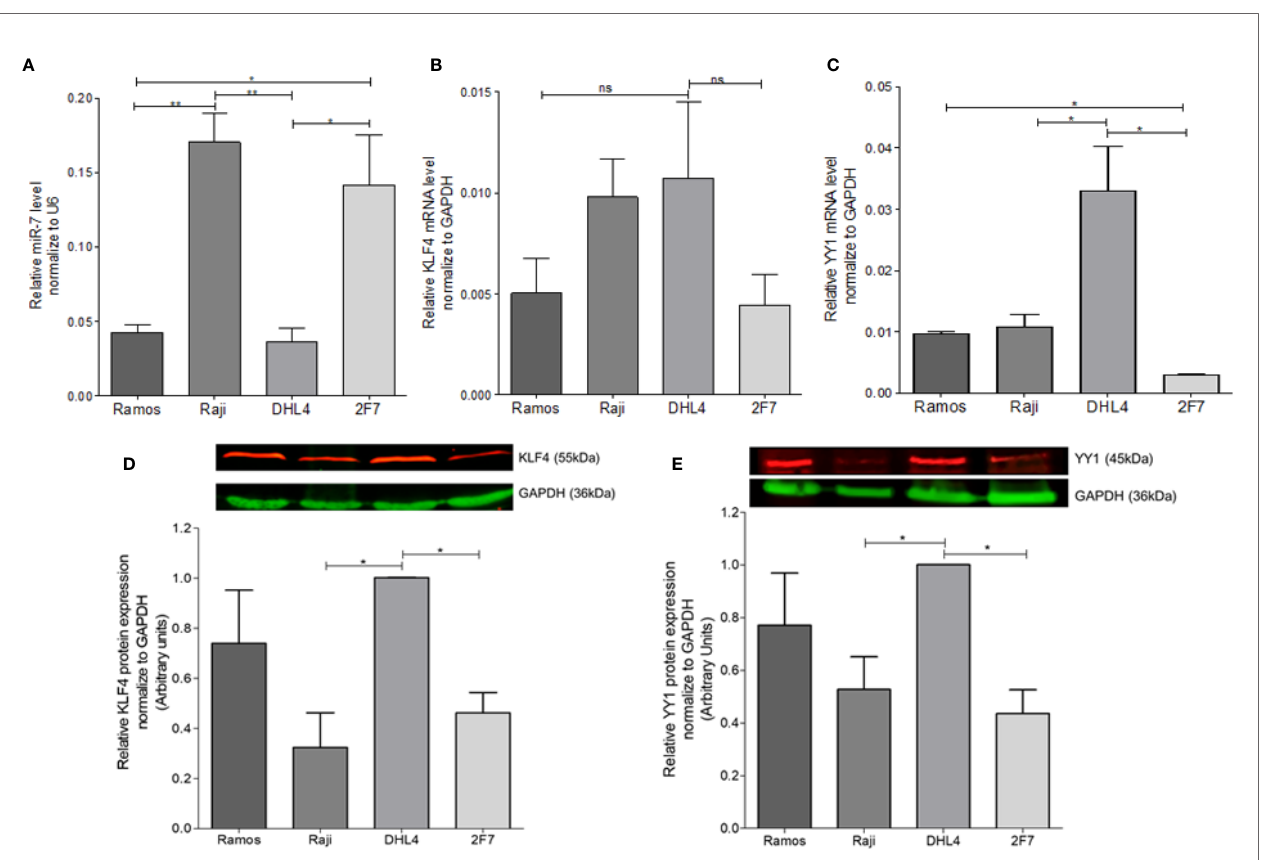
FIGURE 1 | Determination of miR-7, KLF4, and YY1 expression in lymphoma cell lines. (A) miR-7 expression in B non-Hodgkin lymphoma (B-NHL) cell lines was determinate by real time PCR. The values were calculated by the DD Ct method and was evaluated, endogenous control U6 was used as a control. Three-triplicated independents experiments were done and evaluate the relative level, statistical differences are shown (* p < 0.05 **p < 0.01 ). (B, C) KLF4 and YY1 mRNA expression was determinate by Real Time PCR using GAPDH as an endogenous control. Three-triplicated independents experiments were done and evaluate the relative level, statistical differences are shown. YY1 relative levels were signi fi cant (* p < 0.05). (D, E) Representative images of protein expression of KLF4 and YY1 respectively, evaluated by western Blot. The red lines represent the protein expression and in Green the endogenous control (GAPDH). Three independent experiments were done and evaluate the pixel densitometry (arbitrary units) Bottom plots, * p <